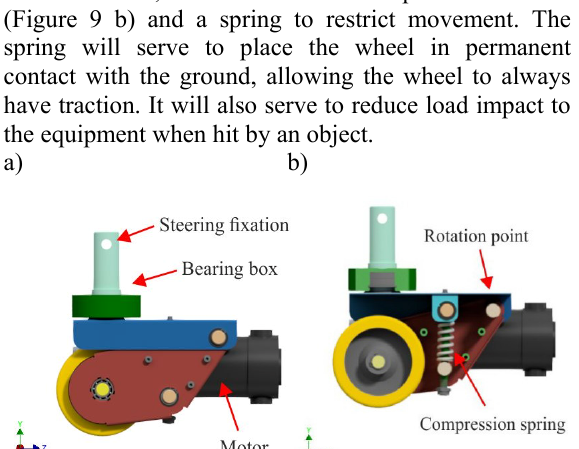
Figure 9. Drive wheel structure: system overview (a) and inside detail of the suspension system (b).